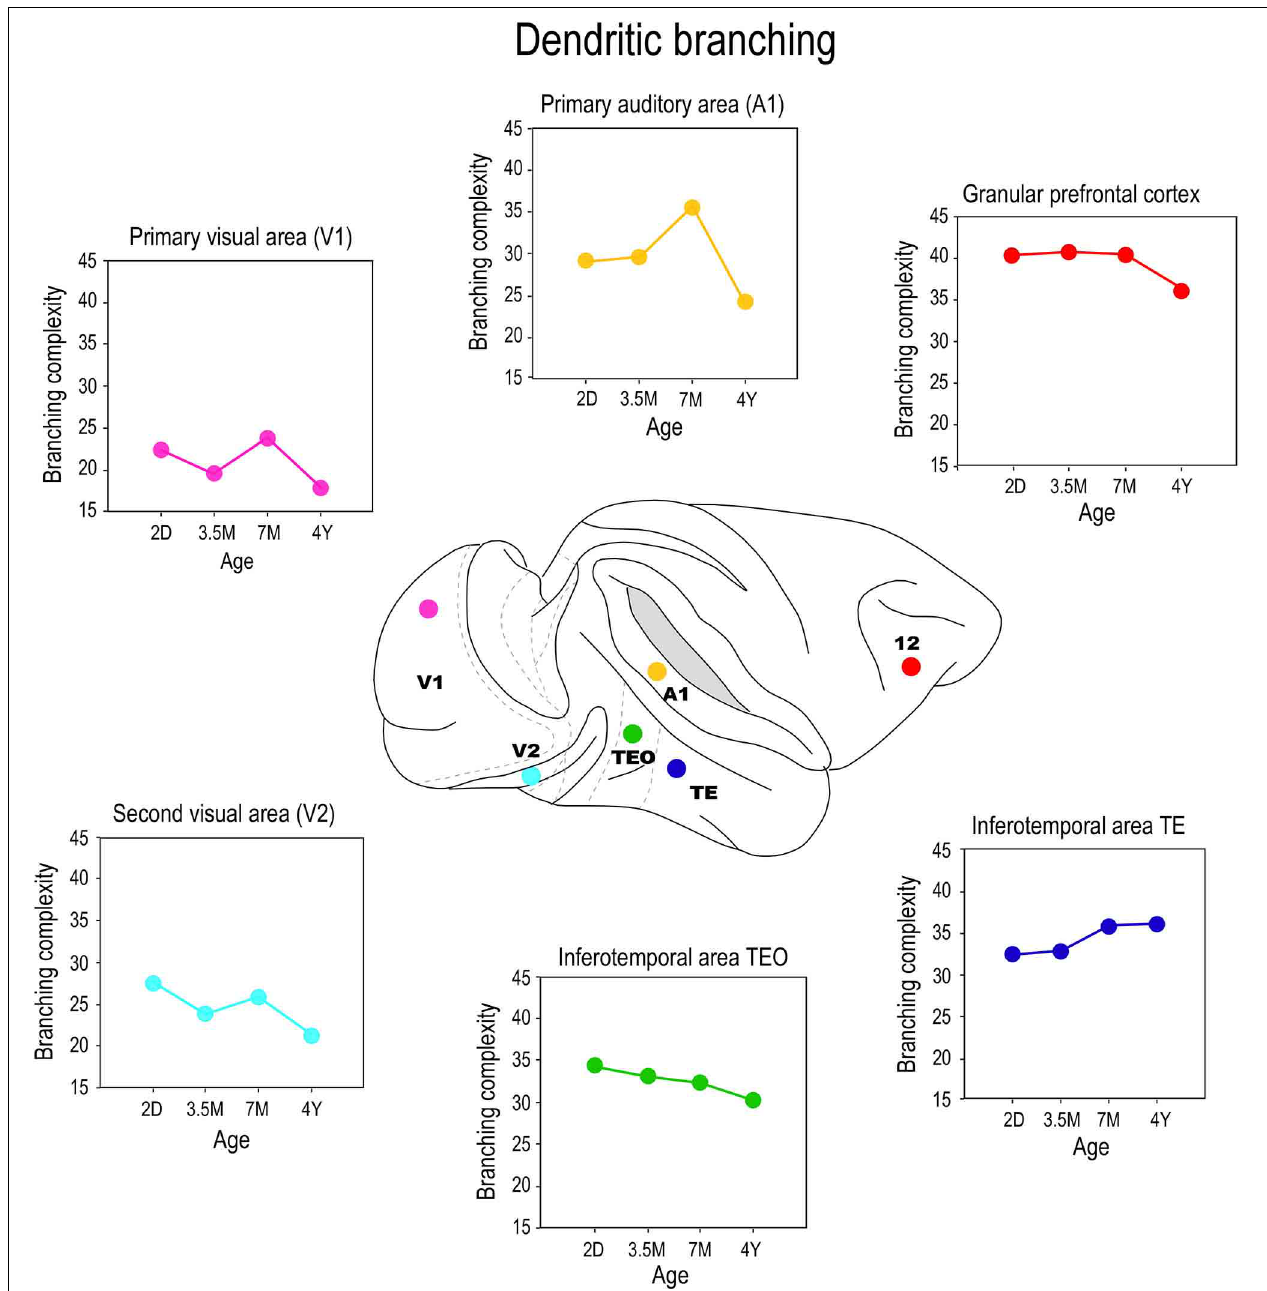
FIGURE 6 | Branching profiles. Plots of the branching structure of the basal dendritic trees of layer III pyramidal neurons sampled from primary visual area (V1), the second visual area (V2), the primary auditory cortex (A1), the posterior and anterior portion of the inferior temporal cortex (TEO and TEav, respectively) and prefrontal cortex (Brodmann’s area 12) at postnatal day two